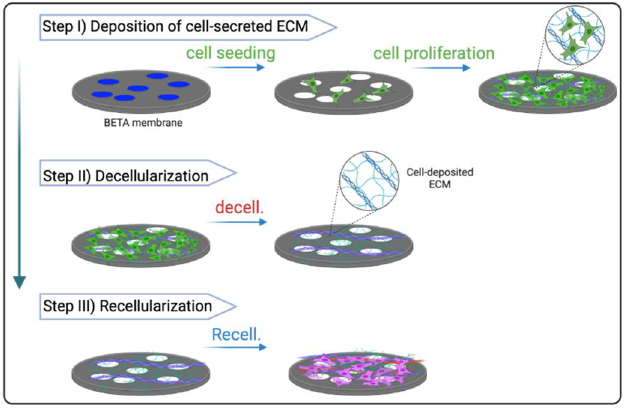
Figure 1. The concept of the ECM-integrated BETA scaffold. First, the biphasic elastic thin for air–liquid culture conditions (BETA) scaffold is populated with the human lung fibroblast cell line (IMR90). After the formation of a confluent cell layer, the membrane is gently decellularized to maintain the aligned and linear proteins of the cell-secreted ECM such as collagens while removing the DNA materials of the fibroblasts. Finally, the hybrid construct of the BETA scaffold and cell-secreted ECM or ECM-integrated BETA scaffold is recellularized with the target pulmonary cells. The schematics were created with BioRender.com (accessed on 27 June 2022).